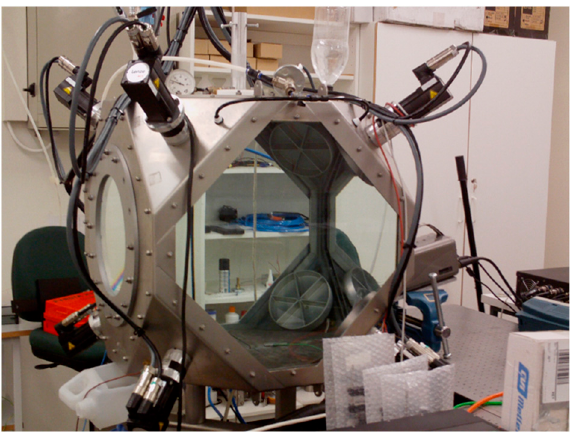
Figure 4. The turbulence flow facility at the Laboratory of Fundamental Turbulence Research, Reykjavik University [18,25,26].